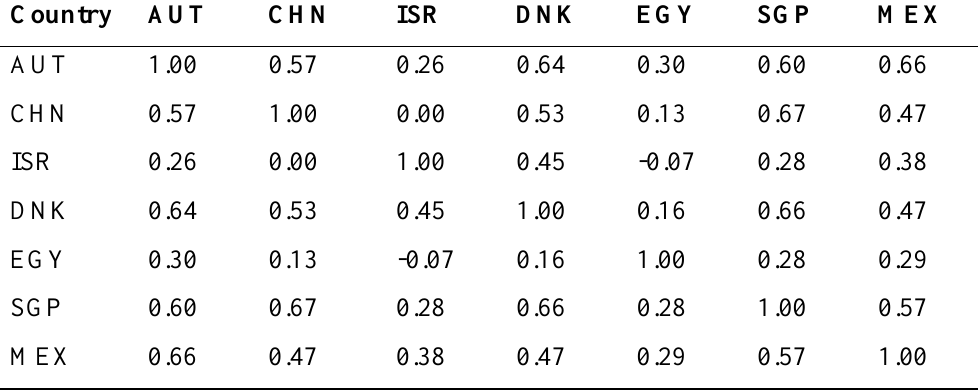
Table 5. Correlation Matrix of Index